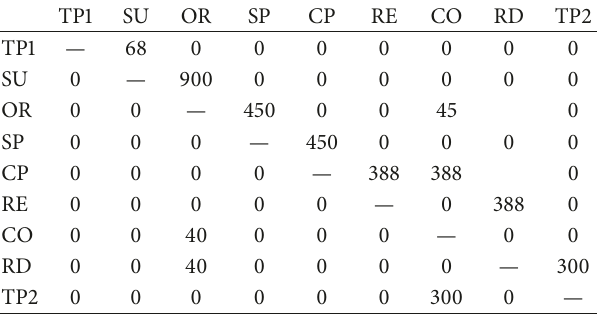
Table 3: “Number of movements” matrix [ 𝑀 ].